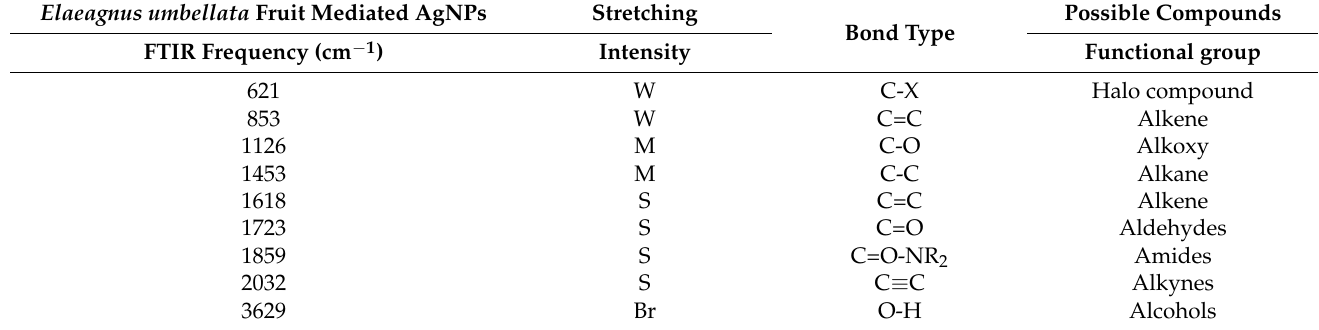
Table 3. FTIR peaks and possible functional groups of Elaeagnus umbellata nanoparticles.